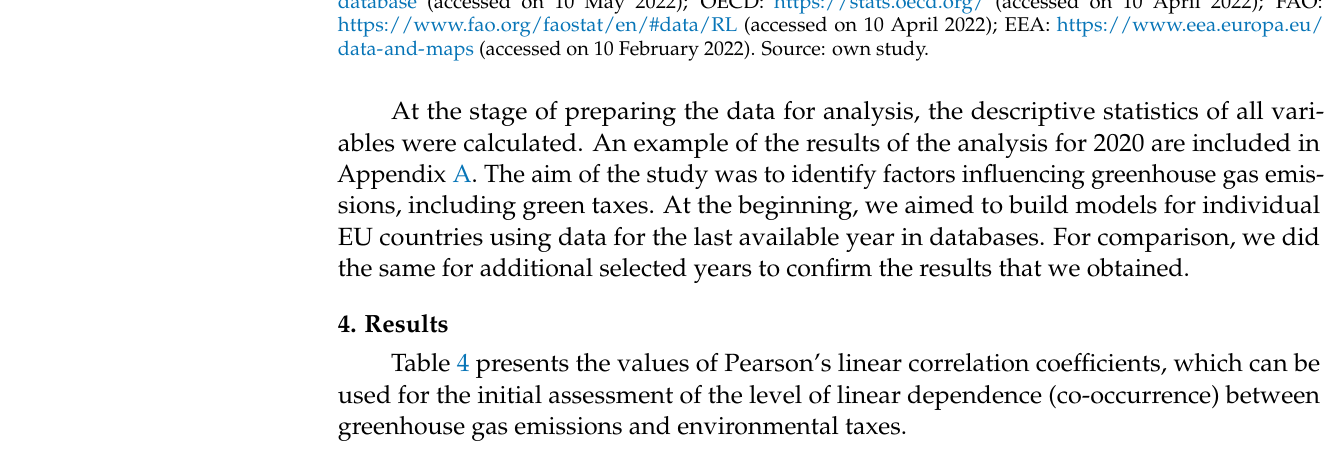
Table 4. Correlation between greenhouse gas emissions and environmental